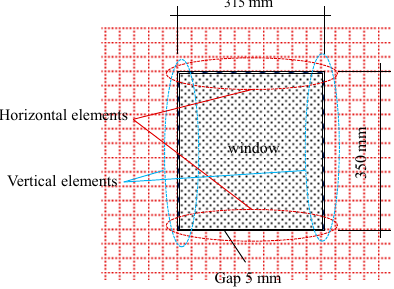
Figure 7. Ventilation network of the storage room: ( a ) horizontal section; ( b ) cross section A–A’; ( c ) cross section B–B’.